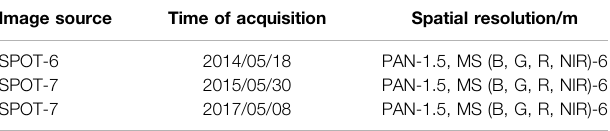
TABLE 1 | Remote sensing data covering the Baige